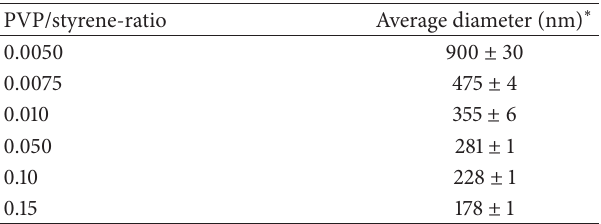
Table 1: Average diameter of the polystyrene templates by varying the PVP/styrene-ratio.